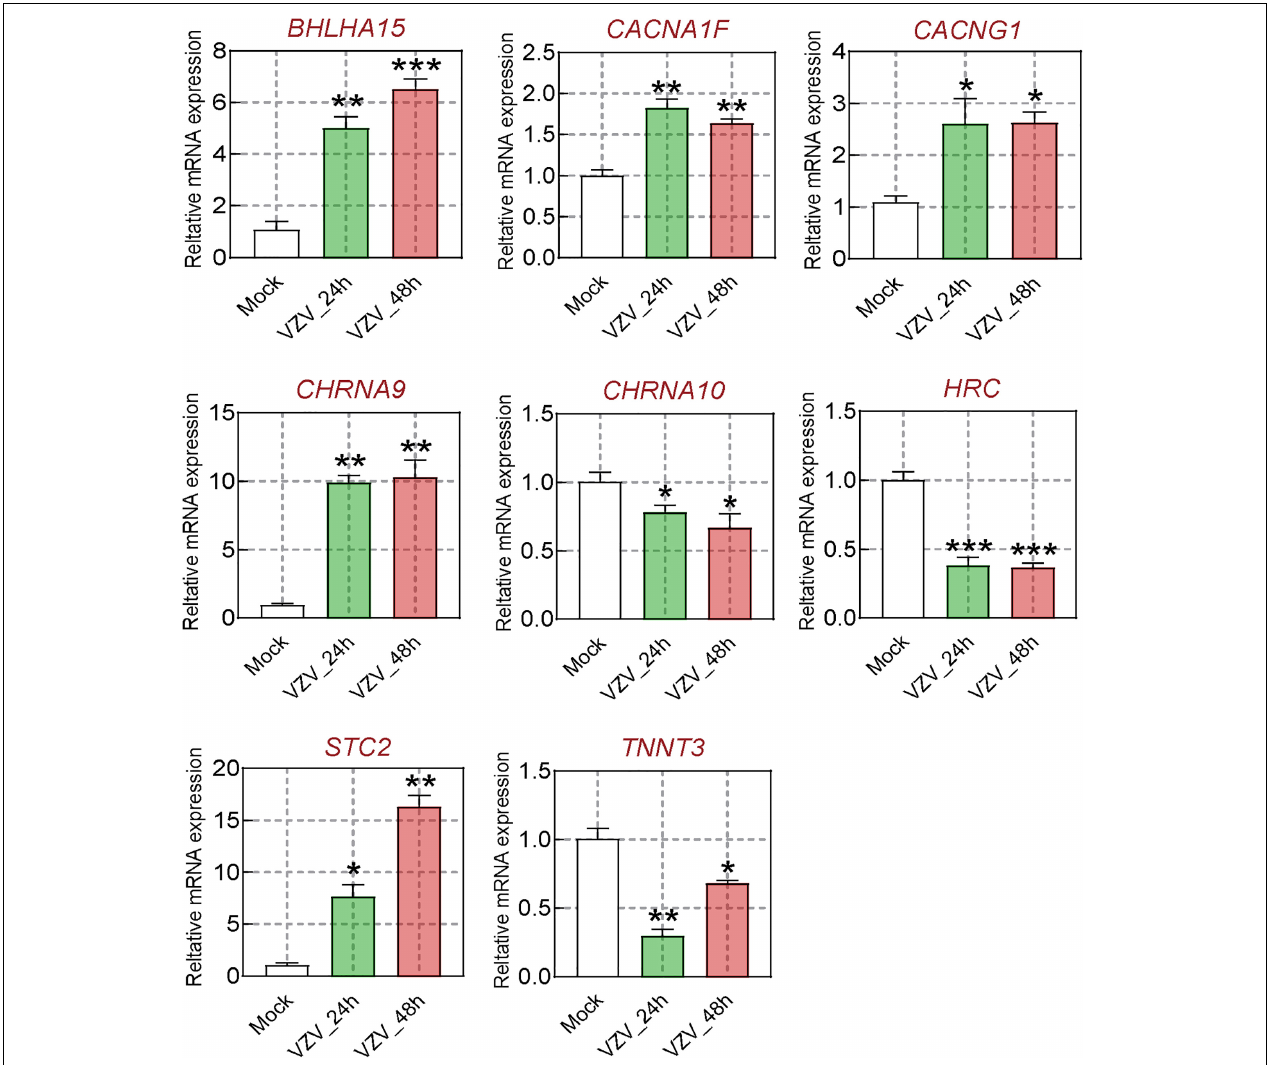
FIGURE 7 | The calcium signal DEGs were verified by qRT-PCR. After VZV-infected SH-SY5Y cells for 24 and 48 h, respectively, qRT-PCR was used to quantify the expression levels of BHLHA15 , CACNA1F , CACNG1 , CHRNA9 , CHRNA10, HRC , STC2 , and TNNT3 genes. Data are expressed as the mean ± SD from at least three independent experiments (compared to the Mock group, * P < 0.05, ** P < 0.01, *** P <